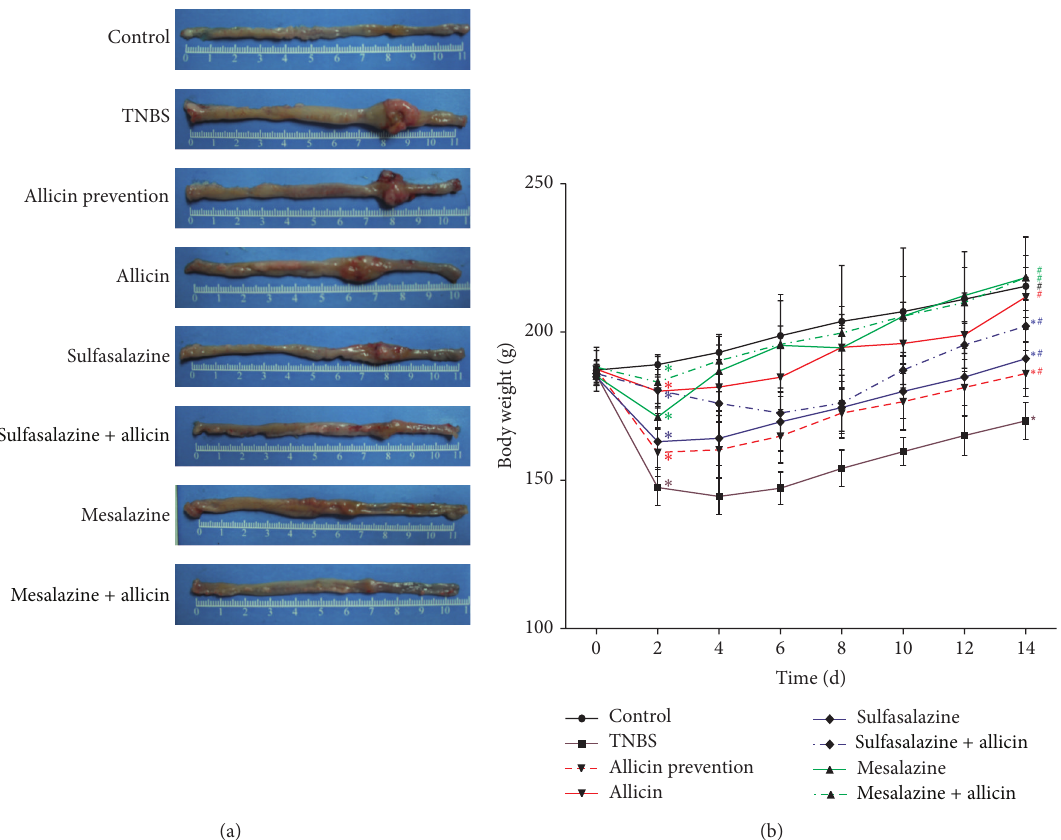
Figure 1: (a) Morphology of the colon in each group. TNBS induced a marked colon lesion, and, 14 days later, different treatments diminished the congestions and intumescences in varying degrees. Allicin combined with sulfasalazine or mesalazine reversed the damage of the colon. (b) The weight curve of rats. The day after the edema, rats lost weight significantly by TNBS inducing, even treated by drugs. At day 14, weights of control, allicin, mesalazine, and mesalazine + allicin groups had no significant difference. Each point represents mean ± SD of each group at certain days ( 𝑛 = 10 in control and mesalazine + allicin groups, 𝑛 = 9 in sulfasalazine group, 𝑛 = 8 in sulfasalazine + allicin group, 𝑛 = 7 in allicin prevention and allicin groups, and 𝑛 = 6 in TNBS and mesalazine groups). ∗ 𝑃 < 0.01 versus control group; # 𝑃 < 0.01 versus TNBS group.